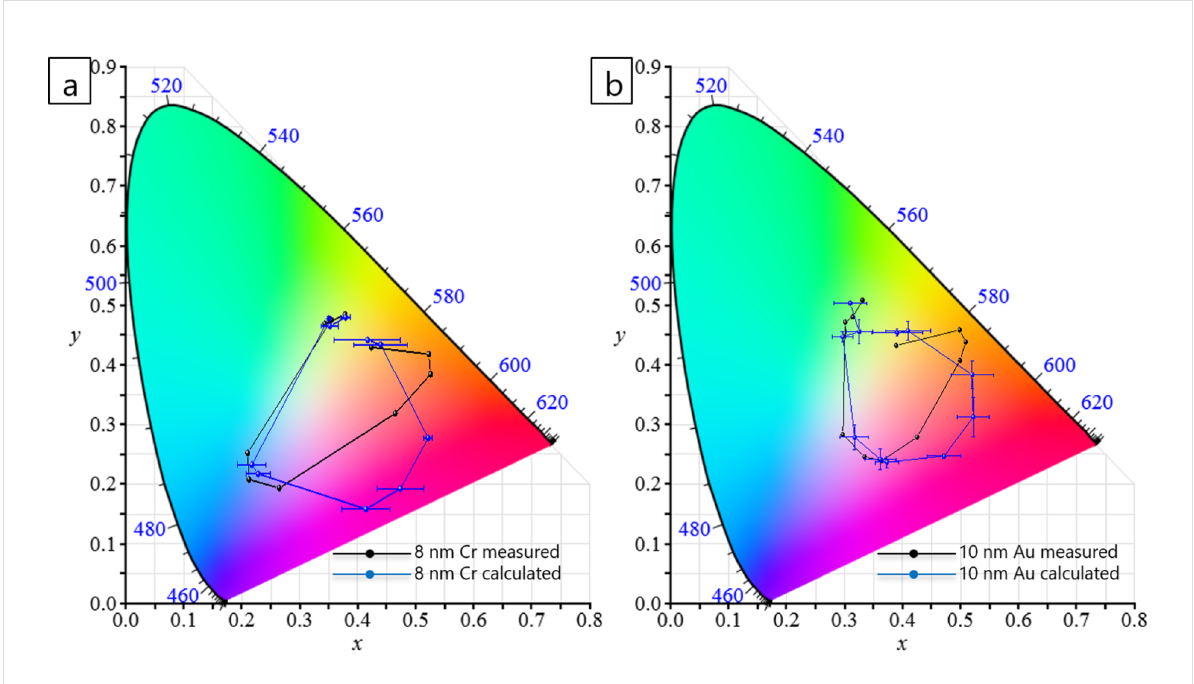
Figure 4: CIE 1931 colour diagrams (a) for 8 nm Cr–AAO–Al and (b) for 10 nm Au–AAO–Al films. Measured values are plotted in black and calcu- lated values in